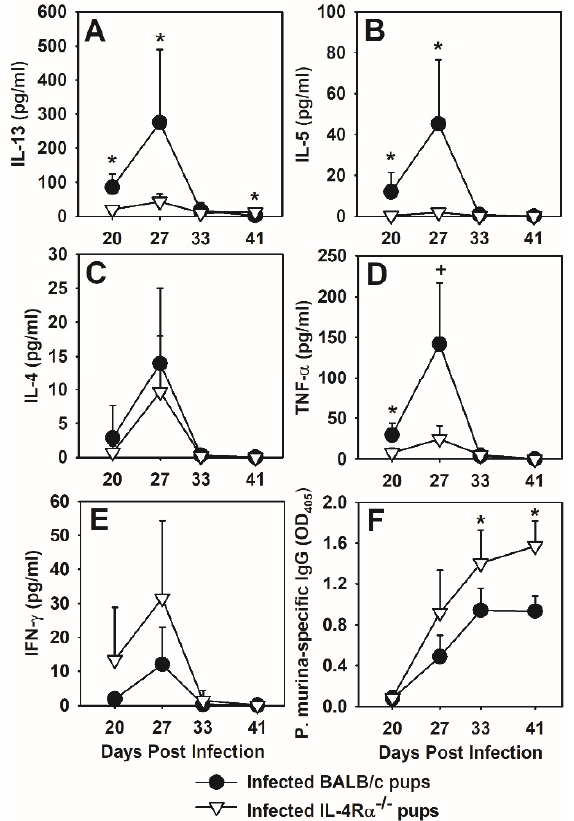
Figure 8. IL-4R α − / − neonates infected with P. murina have a Th1-biased cytokine milieu. Two-day old BALB/c and IL-4R α − / − neonates were infected with 5 × 10 5 P. murina organisms per gram body weight. At indicated days post infection, BALF was collected from 4–7 mice per group. ( A ) IL-13 in the BALF was determined by ELISA. ( B – E ) Levels of IL-5, IL-4, TNF α and IFN γ in the BALF were determined by Cytokine Bead Array. ( F ) Serum P. murina -specific IgG was determined by ELISA. Data represent the mean±SD and are representative of 2 independent experiments. * p ≤ 0.05 com- paring P. murina infected BALB/c neonates to P. murina infected IL-4R α − / − neonates at the same time point.